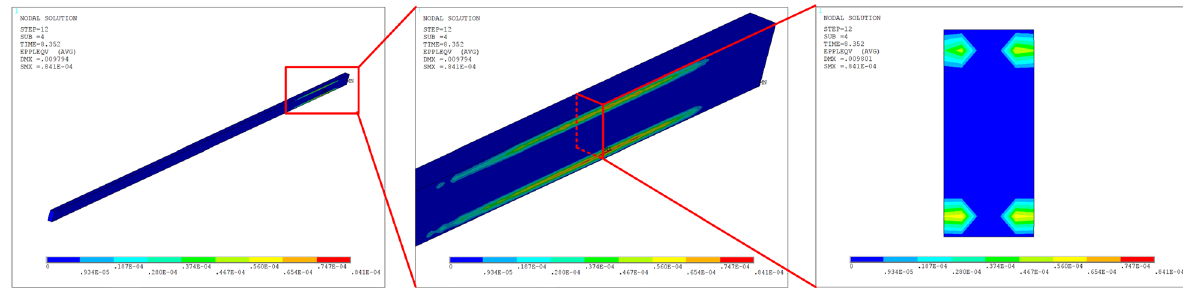
Fig. 22 Cloud diagram of plastic strain at the node of the middle rib pillar of rib pillar